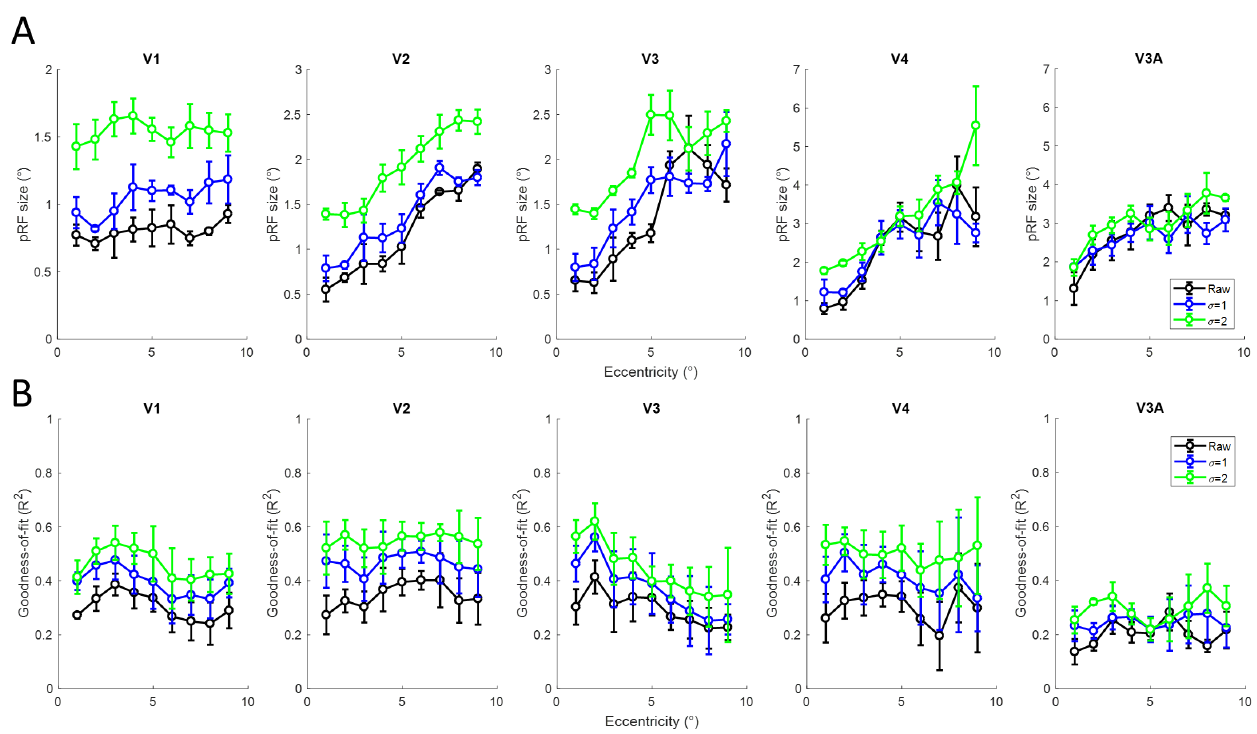
Figure 5. Mean population receptive field (pRF) size ( A ) and median goodness-of-fit ( B ) binned into eccentricity bands for the Auckland data without filtering (black), and low-pass filtering with kernel 1 s (blue) and 2 s (green), averaged across participants. Columns show different visual regions. Error bars denote ±1 standard error of the mean across